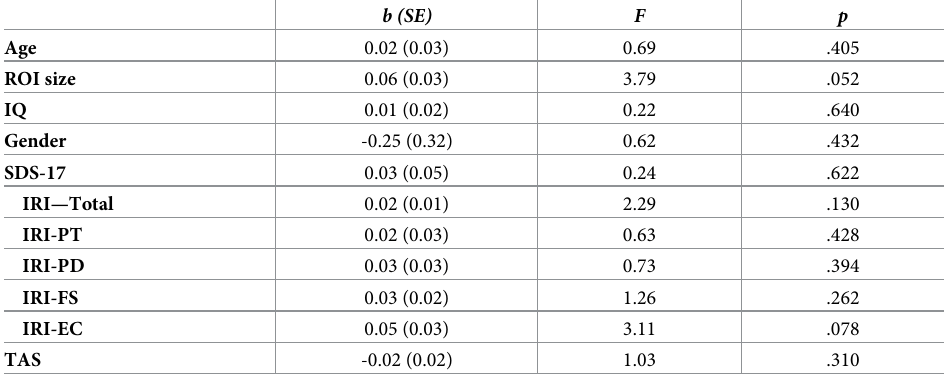
Table 1. Prediction of sociomoral decision-making by control variables using binary logistic